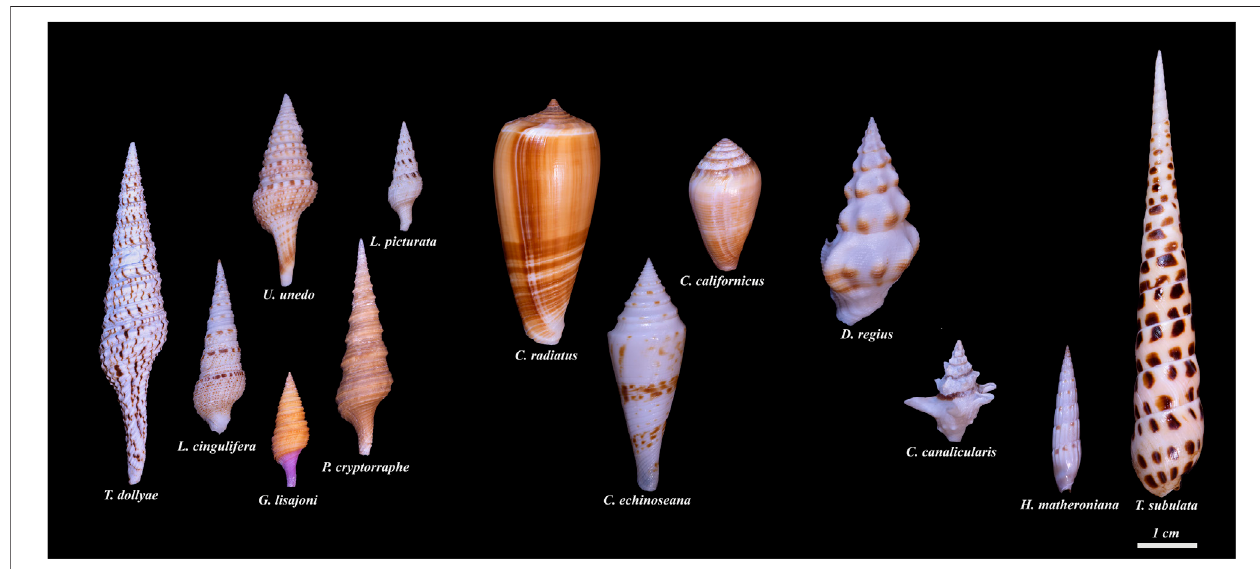
FIGURE 2 | Conoidean families and genera included in the transcriptome-based phylogenetic tree. The six specimens on the left belong to the family Turridae, followed by three specimens in the family Conidae. The two rightmost specimens belong to the family Terebridae and the two next to them are in the family Drilliidae. Starting with the leftmost specimen, and going clockwise: Family Turridae: Turris ( Turris dollyae ); Iotyrris ( Iotyrris cingulifera ); Unedogemmula ( Unedogemmula unedo ); Lophiotoma ( Lophiotoma picturata ); Purpuraturris ( Purpuraturris cryptorraphe ); Gemmula ( Gemmula lisajoni ). Family Conidae: Conus ( Conus radiatus ); Californiconus ( Californiconus californicus ); Conasprella ( Conasprella ichnoseana ). Family Drilliidae: Drillia ( Drillia regia ); Clavus ( Clavus canalicularis ). Family Terebridae: Hastula ( Hastula matheroniana ); Terebra ( Terebra subulata ). The shells were photographed individually and the photographs were cropped to maintain the size of the shells relative to each other. The scale bar represents an approximate length of 1 cm (Photographed by Samuel Espino).